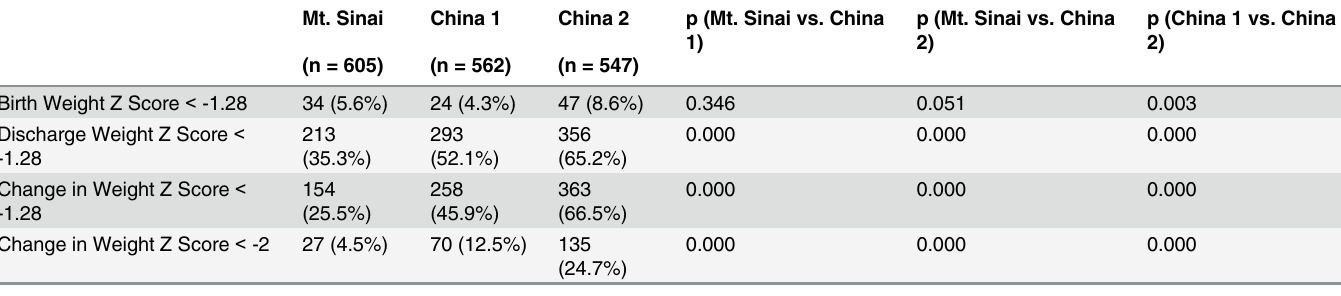
Table 2. Incidences of intrauterine and extrauterine growth restriction of the three groups. Mt. Sinai